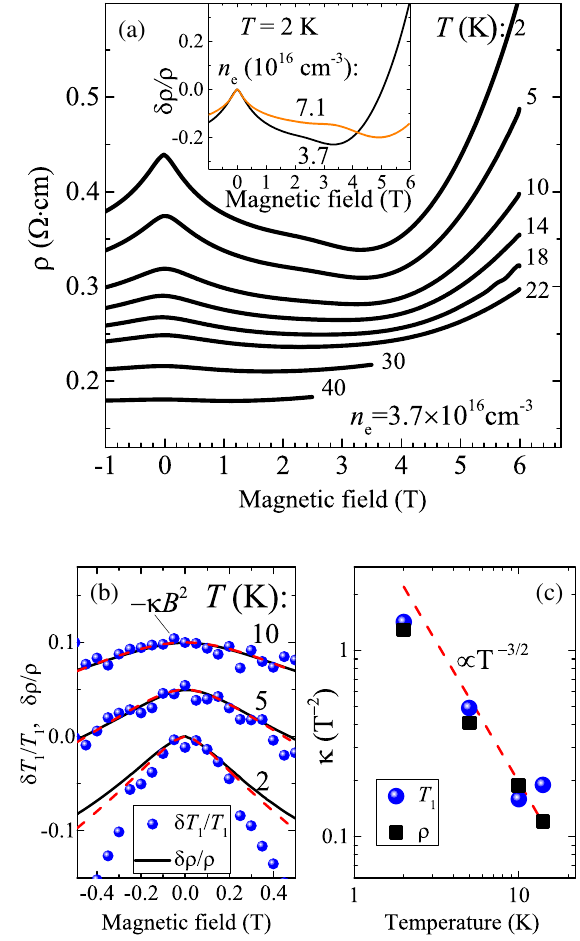
FIG. 3. Evidence of weak localization in resistivity measure- ments. (a) Magnetic field dependence of the resistivity ρ at different temperatures. The inset shows relative variation of ρ with a magnetic field for metallic samples with different electron concentrations. (b) Relative variation of T 1 (the symbols) and ρ (the solid lines) with a magnetic field at different temper- atures. The red dashed lines show fits to both δ T 1 =T 1 and δρ = ρ with Eq. (8). The curves are vertically shifted for clarity. (c) Curvatures of the magnetic field dependencies of δ T 1 =T 1 (the spheres) and δρ = ρ (the squares), κ in Eq. (9), as a function of temperature. The red dashed line shows a T − 3 = 2